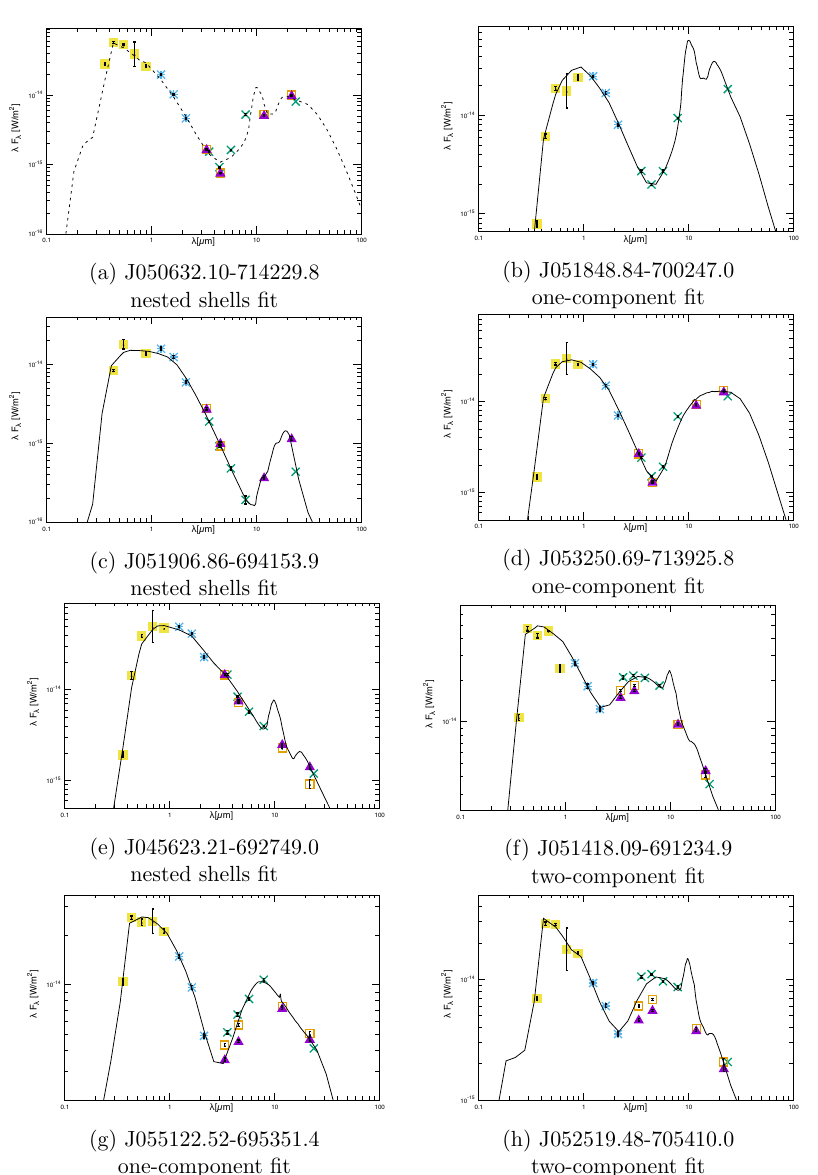
Figure 3. The best–fit models (black curves) to the observed SEDs of the post-AGB sources. The observed fluxes are de-reddened for Galactic and LMC reddening. U, B, V, R, I (yellow), 2MASS J, H and K (cyan) data are plotted along with WISE (purple) and ALLWISE (orange) photometry and data from the SAGE-LMC Survey (green), which covers the IRAC and MIPS bands. The error bars and upper limits (arrows) are indicated in